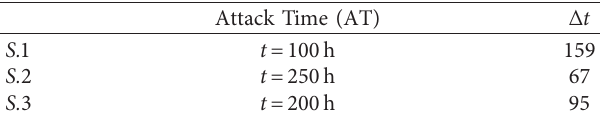
Table 2: Recovery time interval of No. 2 pipeline by one attack at different